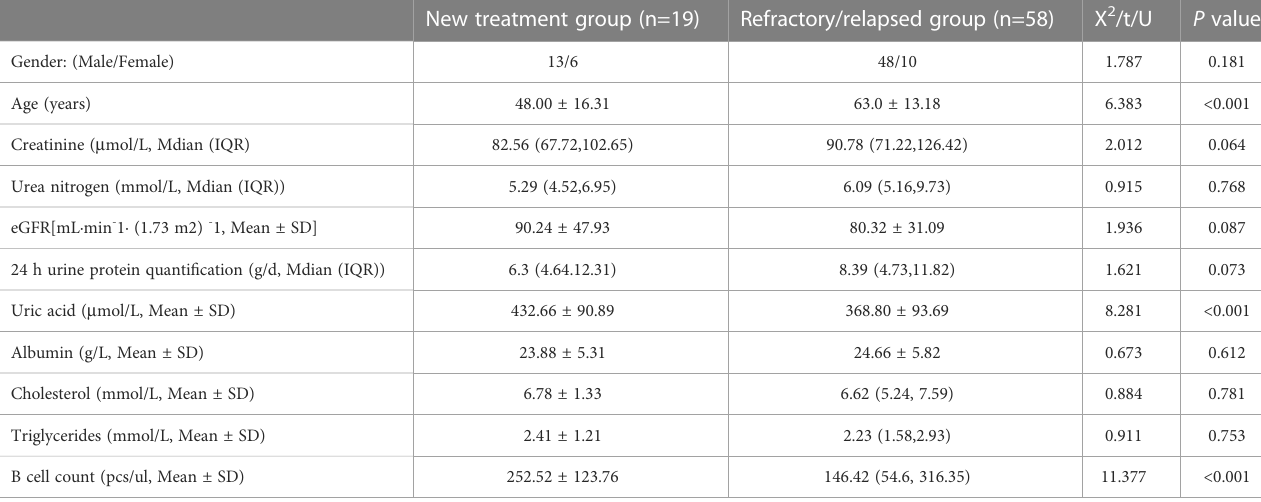
TABLE 1 Comparison of baseline data of two groups of patients.